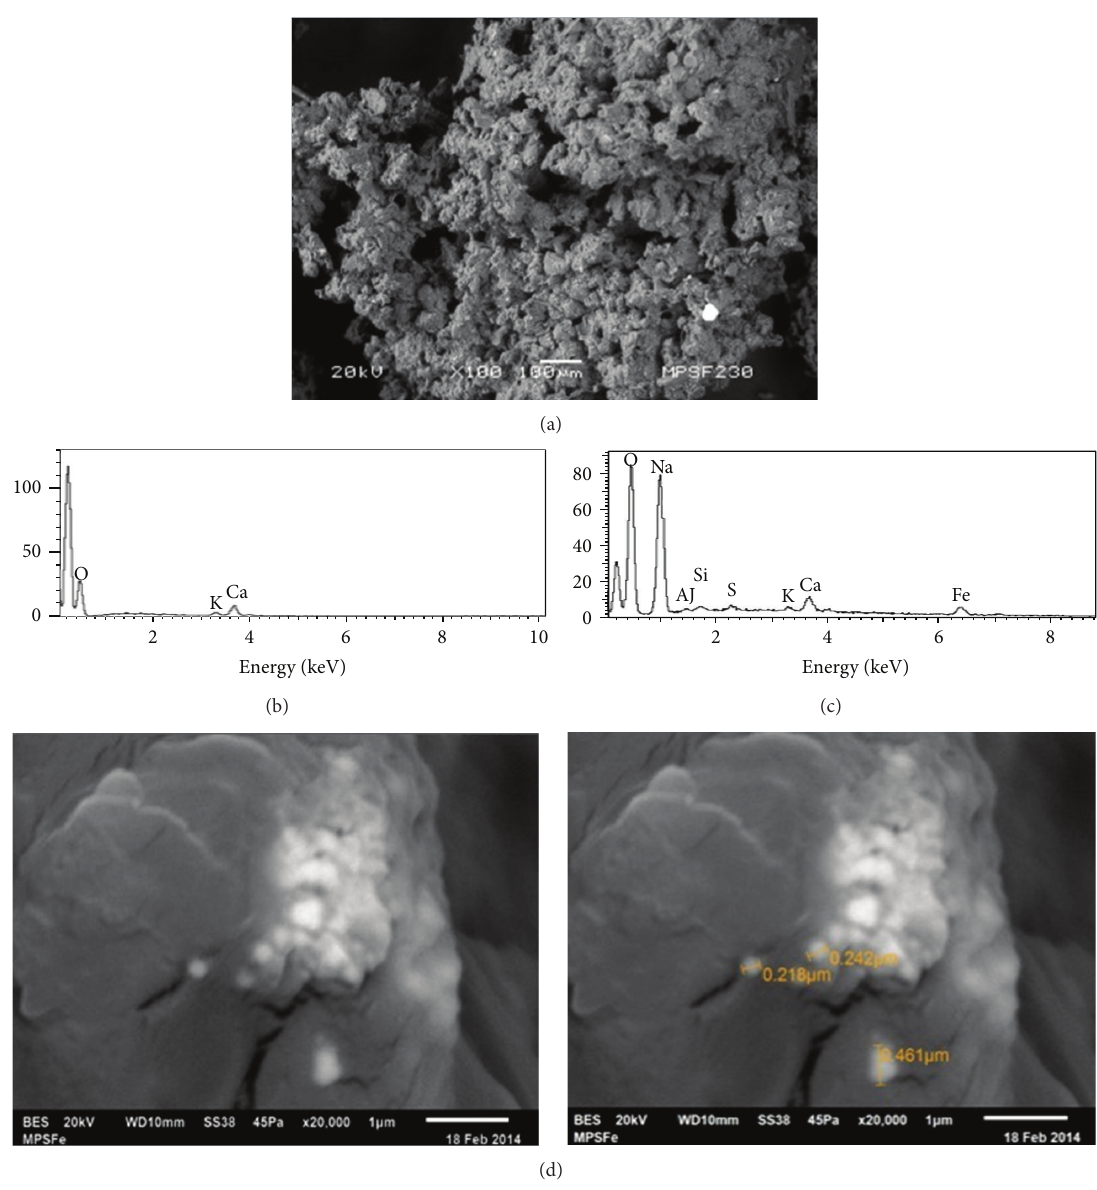
Figure 10: SEM/EDS images for the synthesized